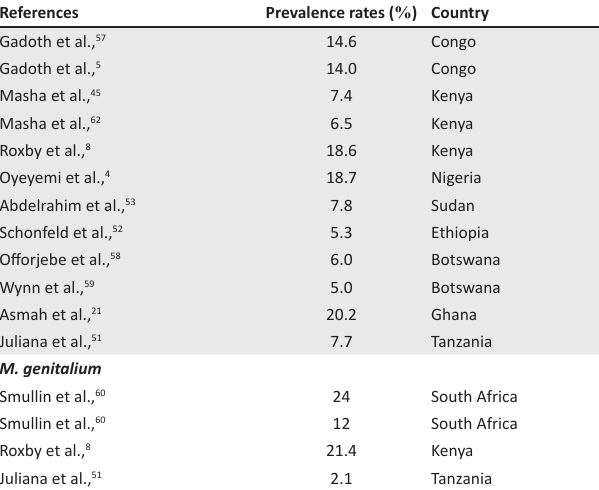
TABLE 1 (Continues...): Summary of prevalence data for sexually transmitted infections in pregnant women from sub-Saharan